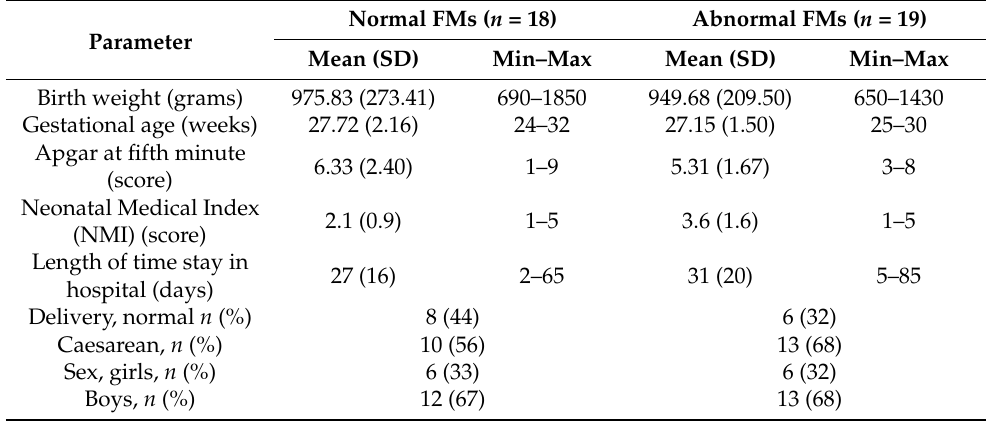
Table 1. Characteristics of the groups of infants with normal FMs and infants with abnormal FMs.